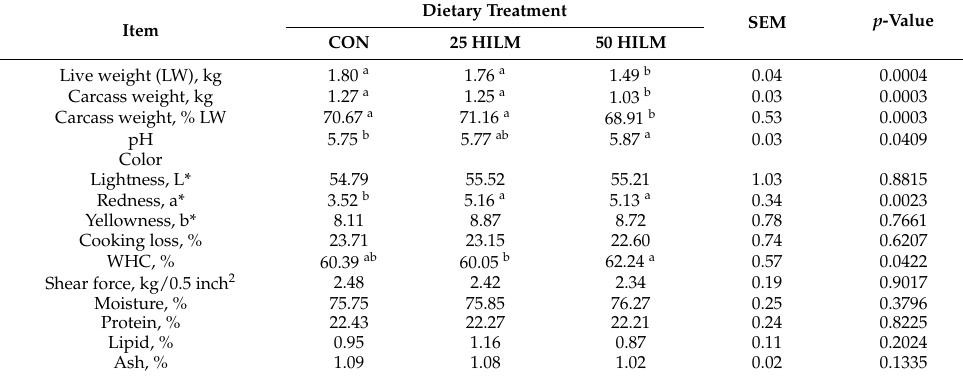
Table 4. Effect of dietary Hermetia illucens larvae meal (HILM) inclusion level on the carcass and breast meat traits of broiler